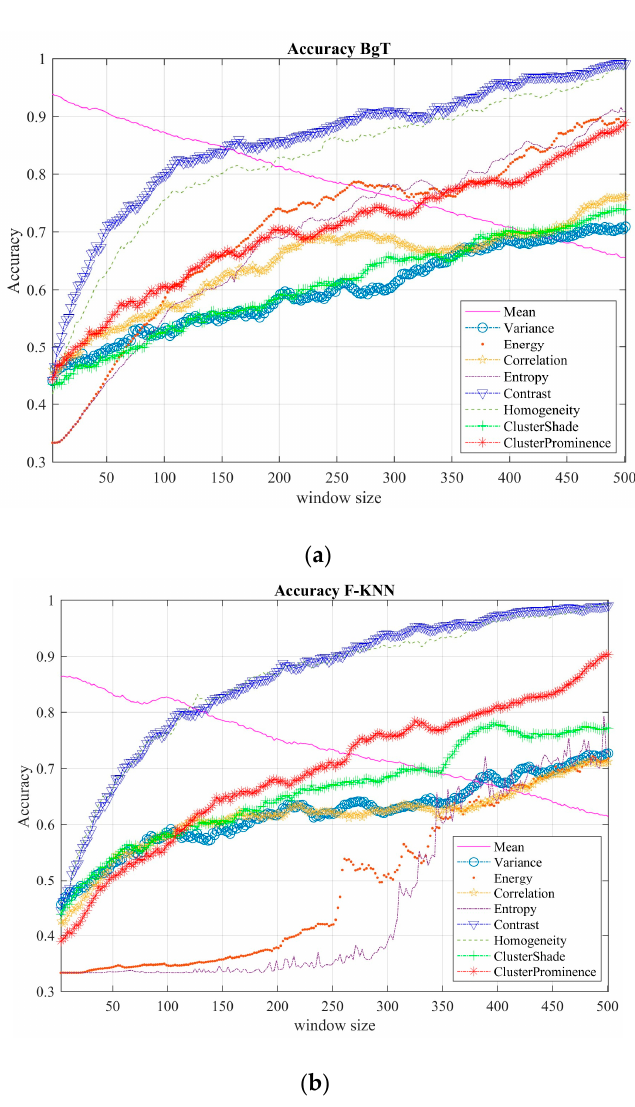
Figure 5. Comparison of the classification results for di ff erent texture features. ( a ) For the BgT classifier and ( b ) for the F-KNN classifier.